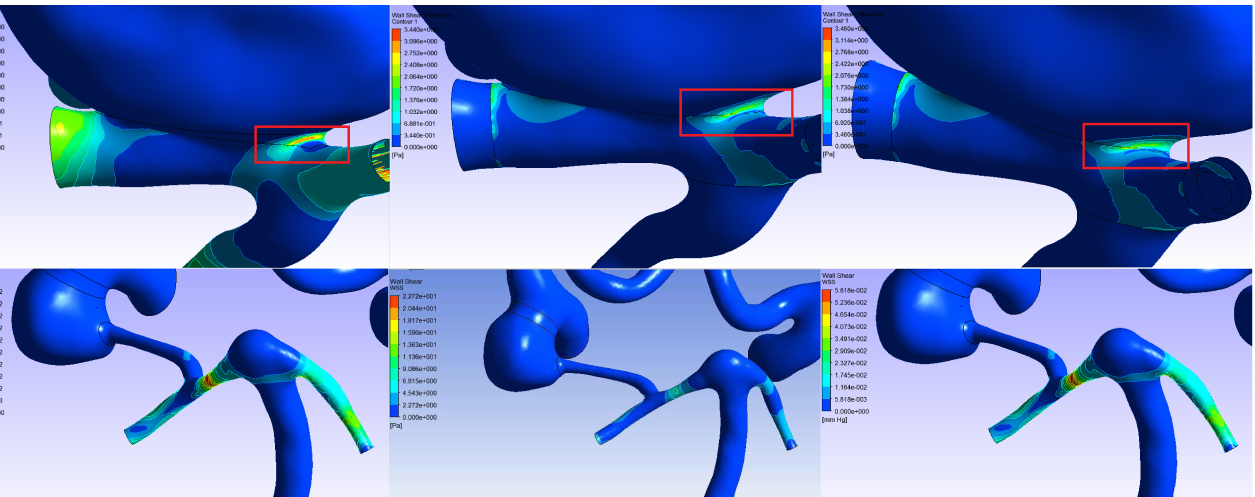
Figure 6. (On the left ) Establishing of a Poiseuille velocity profile in the vessel with respect to distance from the inlet, where 0 corresponds to inlet boundary conditions, 0.25 d, 0.5 d, 0.75 d and d–slices, corresponds to value of the velocity through vessel slices, which are located at the correspond distance from the inlet (d-corresponds vessel diameter at the inlet), (on the right ) Numerical (blue in the graph) and exact (orange in the graph) solutions for blood flow velocity profile in the vessel at a distance of d from the inlet.